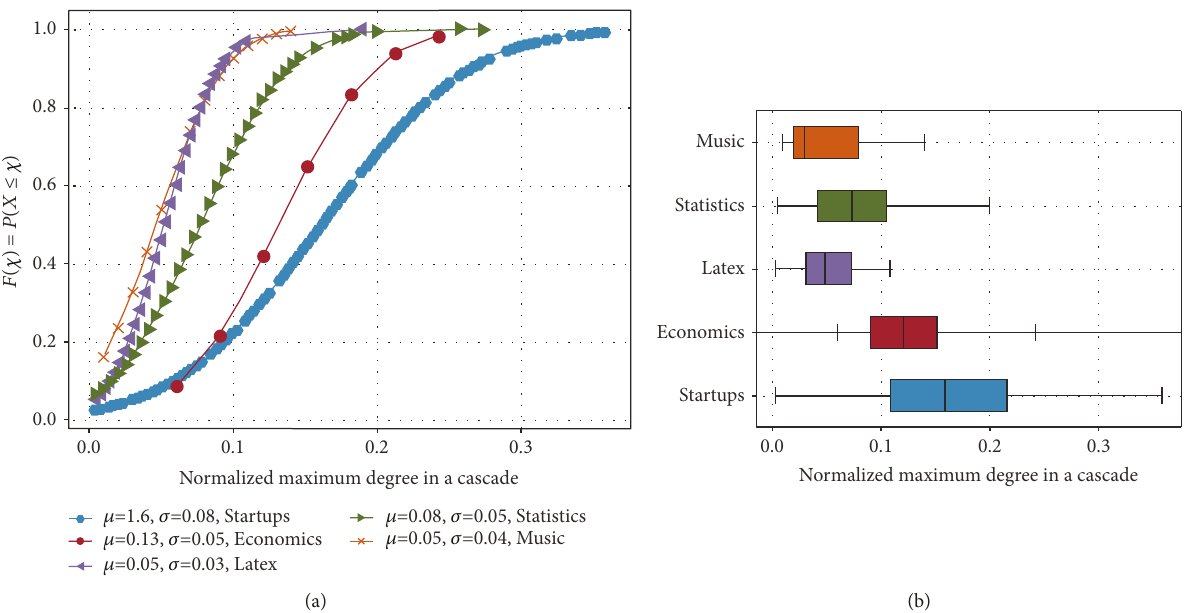
Figure 4: The fi gure shows the normalized maximum degree of a node in the observed cascades as CDF (a) and as box plots